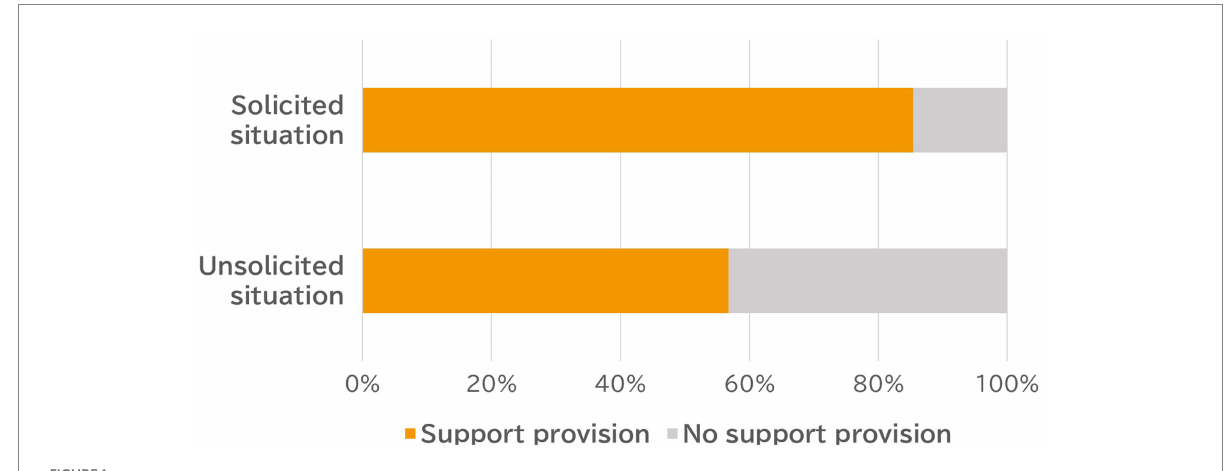
FIGURE 1 Provision rate of solicited and unsolicited social support among Japanese